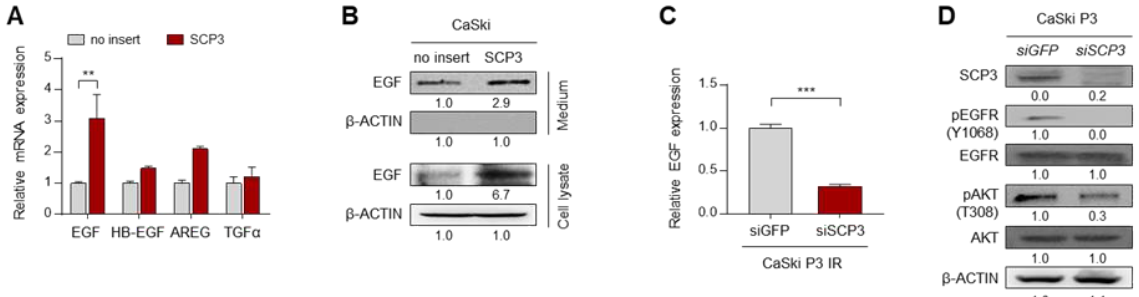
Figure 2. SCP3 activates EGFR-AKT signaling through transcriptional induction of EGF. ( A ) mRNA expressions of EGF, HB-EGF, AREG, and TGF α was analyzed by qRT-PCR. ( B ) The protein levels of secreted EGF and internal EGF were evaluated by Western blot analysis of the conditioned medium and lysate of these cells. ( C , D ) CaSki P3 cells were transfected with siGFP or siSCP3 . ( C ) EGF mRNA expression was analyzed by qRT-PCR. ( D ) The levels of SCP3, pEGFR, EGFR, pAKT, and AKT were analyzed by Western blots. β -ACTIN was used as an internal loading control. ( B , D ). All experiments were performed in triplicate. The p -values were determined by unpaired, two-tailed Student’s t -test. The data represent the mean ± SD (** p ≤ 0.01, *** p ≤ 0.001).